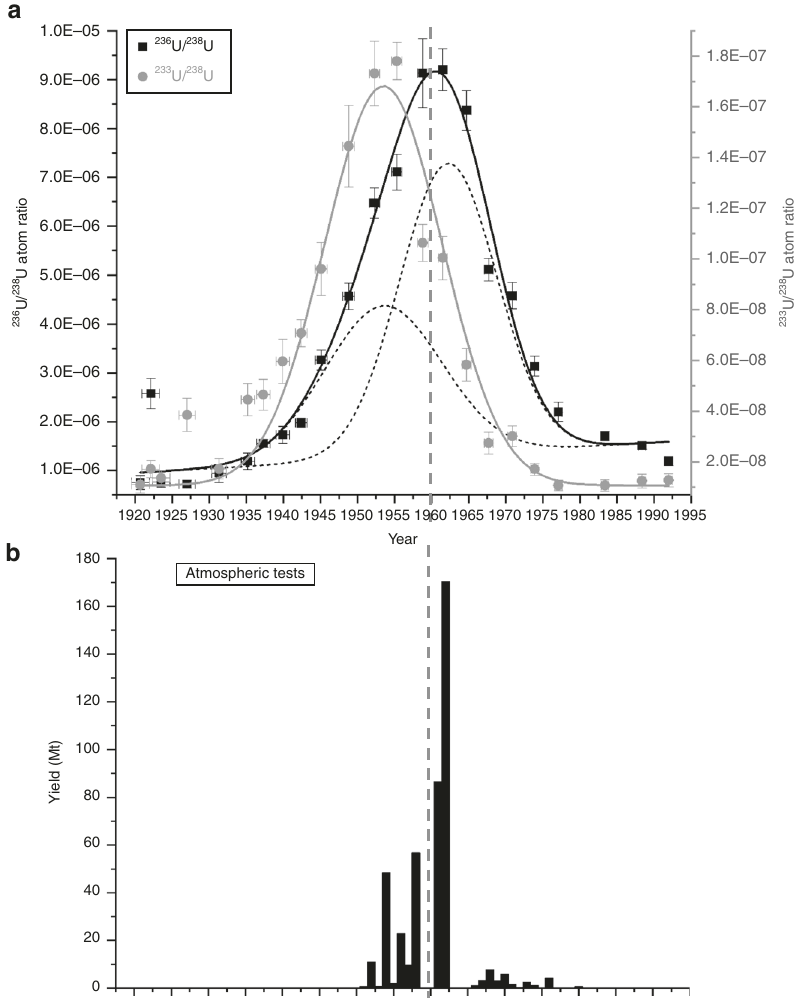
Fig. 1 233 U and 236 U signal in the peat bog compared with weapons yields. a Measured 236 U/ 238 U (black squares) and 233 U/ 238 U (gray dots) atom ratio in the peat core depending on the age of the peat layer. The measurement uncertainties shown are ±1 σ (s.e.m.). The solid lines represent a Gaussian fi t of the 236 U (black line) and the 233 U (gray line) data indicating a time shift between the 233 U and the 236 U release. The 236 U peak can be disentangled by two Gaussian distributions (dashed black curves in a ) corresponding to the two major testing phases of nuclear weapons with respect to the explosion yield (1952 – 1958 and 1961 – 1962) shown in b 39 . The vertical dashed gray line marks the year 1960 for a direct comparison of the time scales in a and b